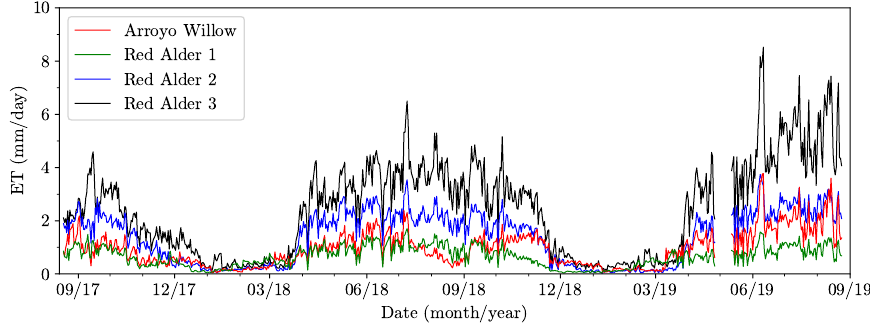
Figure 8. Evapotranspiration (mm/d) of the four instrumented trees from 18 August 2017 through 24 August